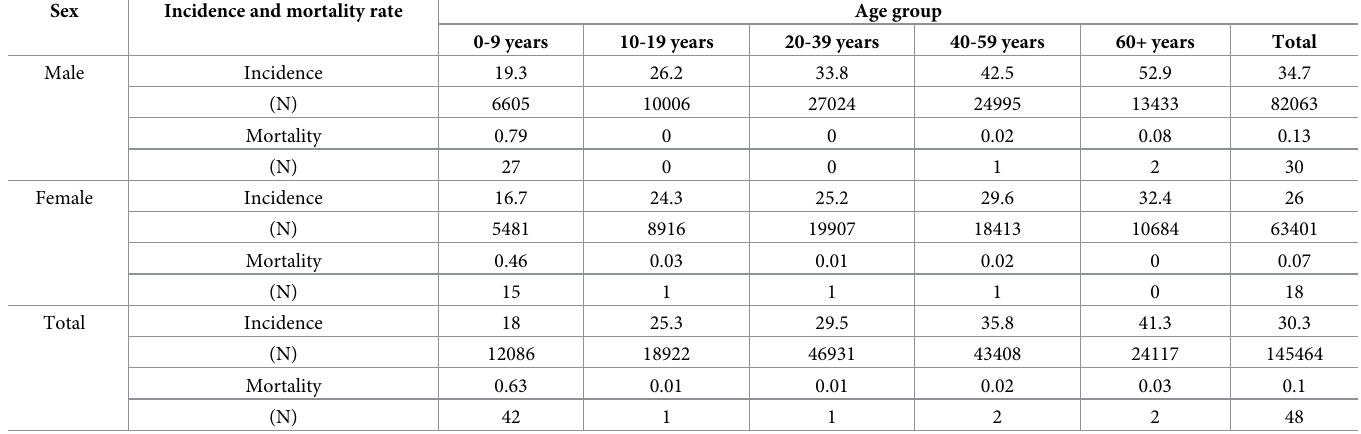
Table 1. Number of cases and deaths resulting from scorpion envenomation by age and sex and respective rates of incidence (100,000 inhabitant-years) and mortal- ity (1,000,000 inhabitant-years) in the state of S ã o Paulo, Brazil from 2008–2018. Sex